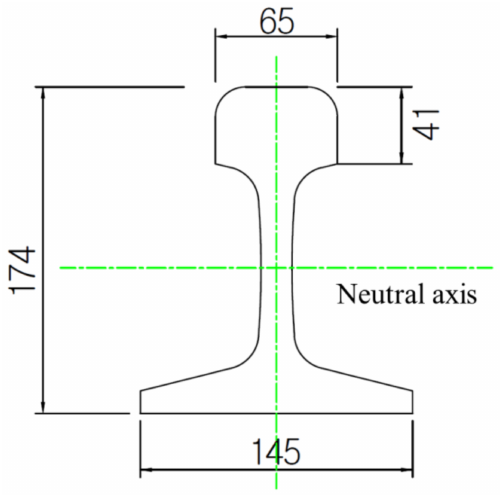
Figure 3. Cross-section of a KR60 rail [42].